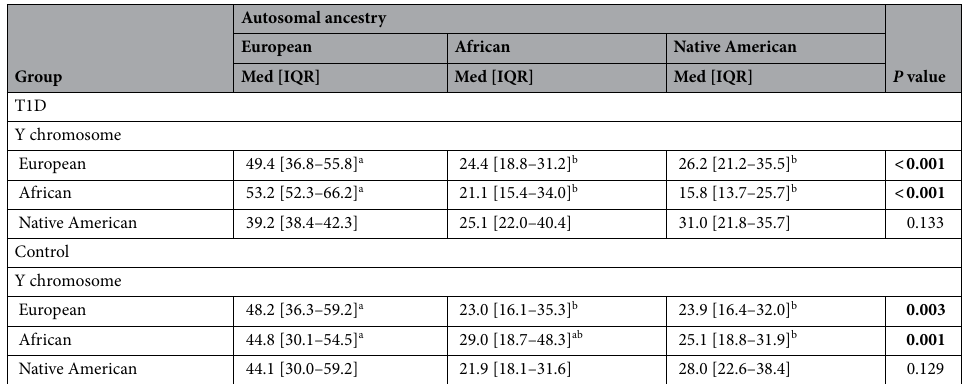
Supplementary Fig. 2Sb online shows the distribution of HLA-DQA1 according to the self-declared color. There was an uneven distribution among the color categories. Among self-reported blacks, the highest frequency was 03:01, while in brown and white it was 05:01.